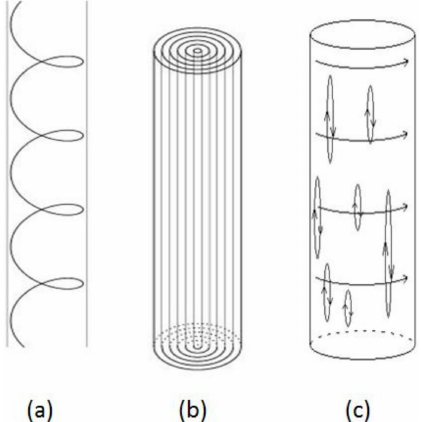
Figure 6. Three possible magnetic field configurations discussed in the text. ( a ) a vector-ordered helix. The side to side asymmetry is obvious if the jet is not viewed from a direction perpendicular to its axis; ( b ) two-dimensional field sheets wrapped around the jet axis; ( c ) a toroidal field plus longitudinal loops. Both configurations ( b , c ) reproduce the observed polarization properties of jets, while avoiding some of the problems associated with completely vector-ordered fields (see text). Figure 6a,b are taken from [27]. Figure 6c is taken from